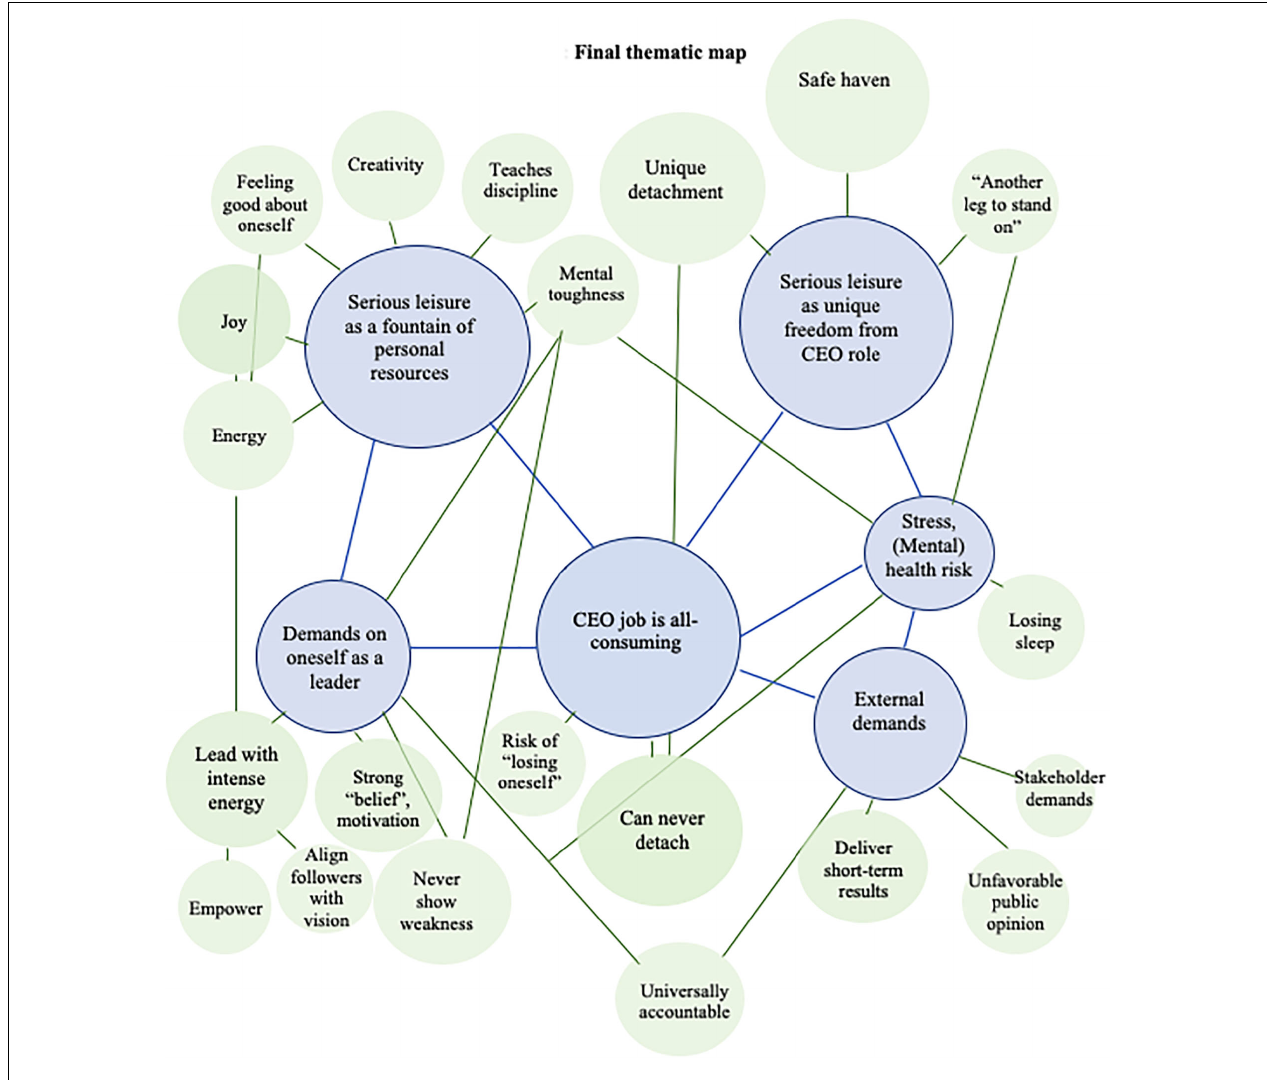
FIGURE 1 | Final thematic